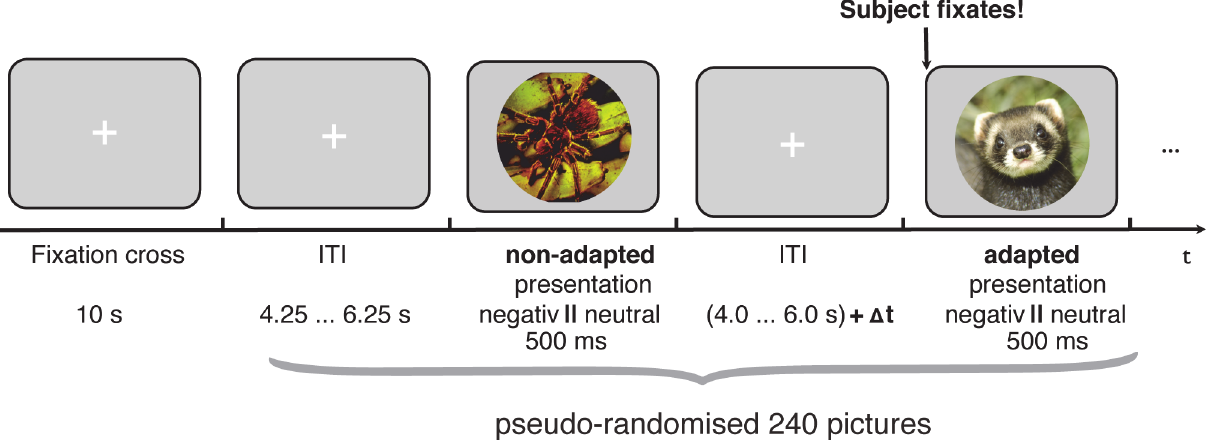
Fig 3. Experimental paradigm. The experiment ’ s paradigm consisted of 60 negative and 60 neutral IAPS pictures, each presented in adapted and non- adapted manner over the course of the experiment. Each picture was presented for 500 ms with a fixation cross in between. In the adapted condition the picture presentation was shifted in time until subjects directed their gaze position toward the center of the screen and hence fixated the center of the subsequently presented picture. The main purpose of the study was to investigate the benefits of this trial adaptation.